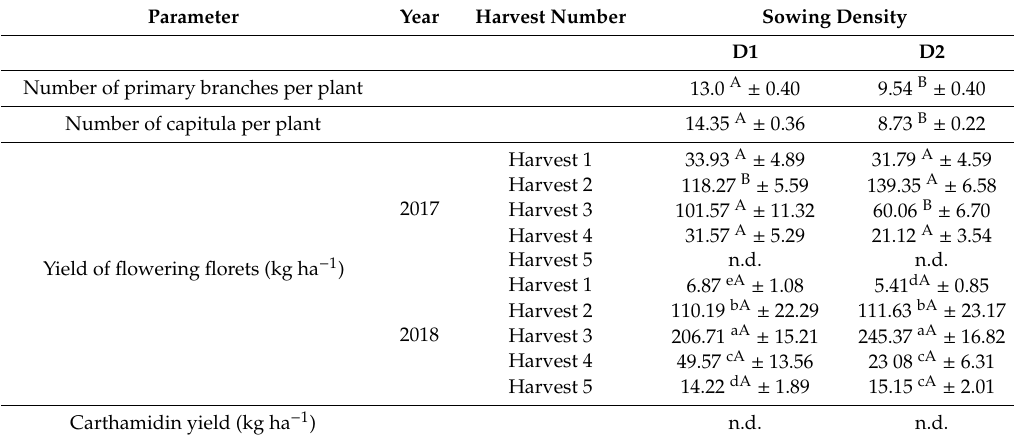
Table A2. Mean values ± standard error and significant di ff erences of the Fisher’s LSD test ( α = 0.05) for the factors year (2017 and 2018), harvest date (Harvest 1–5), and sowing density (D1 and D2). Mean values with at least one identical lowercase letter are not significantly di ff erent between harvest dates (within columns). Mean values with at least one identical capital letter are not significantly di ff erent between sowing densities (within rows).